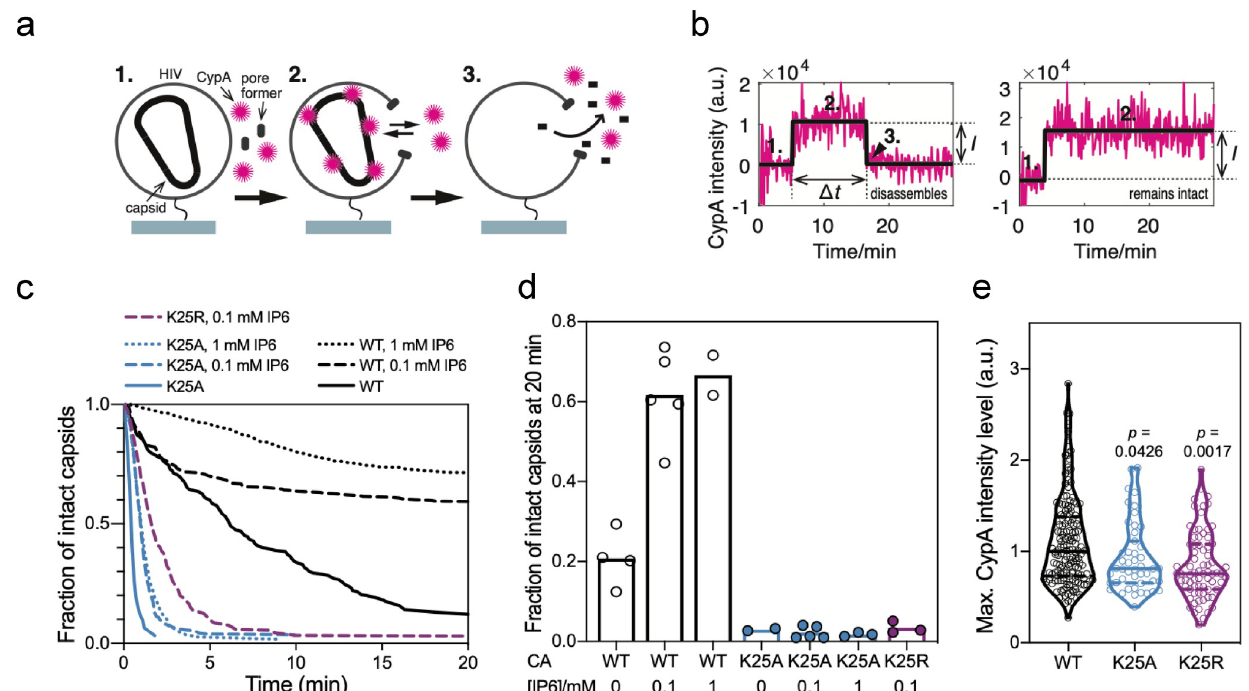
Fig 4. CA K25 mutants capsids are short-lived in the absence and presence of IP6. (a) Schematic of the capsid uncoating assay using TIRF microscopy and the CypA paint method. Immobilized viral particles are permeabilized in the presence of fluorescently labeled CypA while recording fluorescence traces at the locations of single virions (1). CypA binds to the capsid, resulting in the appearance of a stable fluorescence signal (2). Capsid disassembly results in the disappearance of the CypA signal (3). (b) Example traces for a capsid that disassembles (left) and a capsid that remains intact (right) during the acquisition time. The fluorescence traces (magenta) are analysed by step fitting (black) to extract lifetime ( Δ t ) and intensity ( I ) for each capsid. (c) Capsid survival curves generated from single-virion uncoating traces. CA K25A mutant capsids fall apart rapidly and IP6 does not stabilise CA K25A or K25R capsids, unlike wild type capsids. (d) Bar graph of the fraction of capsids that remain intact 20 min after permeabilization of the viral membrane. (e) Intensity distributions of the CypA paint signal. The intensity is proportional to the size of the CA lattice. The lower median intensity for K25 mutants compared to wild type suggests the presence of a smaller CA lattice. Comparisons using the Kolmogorov-Smirnov test.